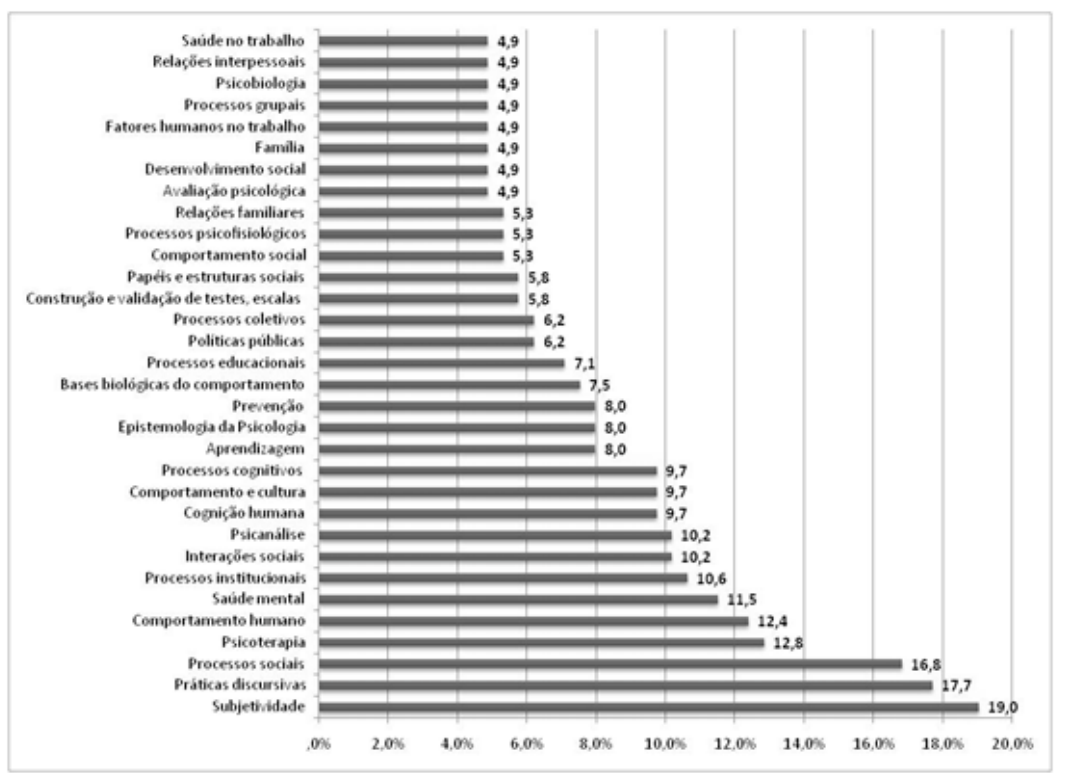
Figura 3 . Distribuição percentual dos temas/especialidades mais presentes nas Linhas de Pesquisa dos Progra- mas de Pós-Graduação em